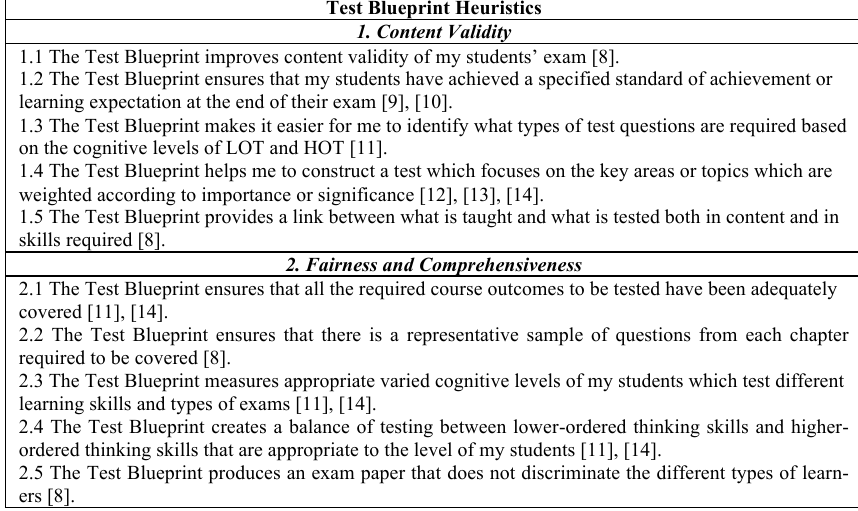
Table 4. Specialized Domain